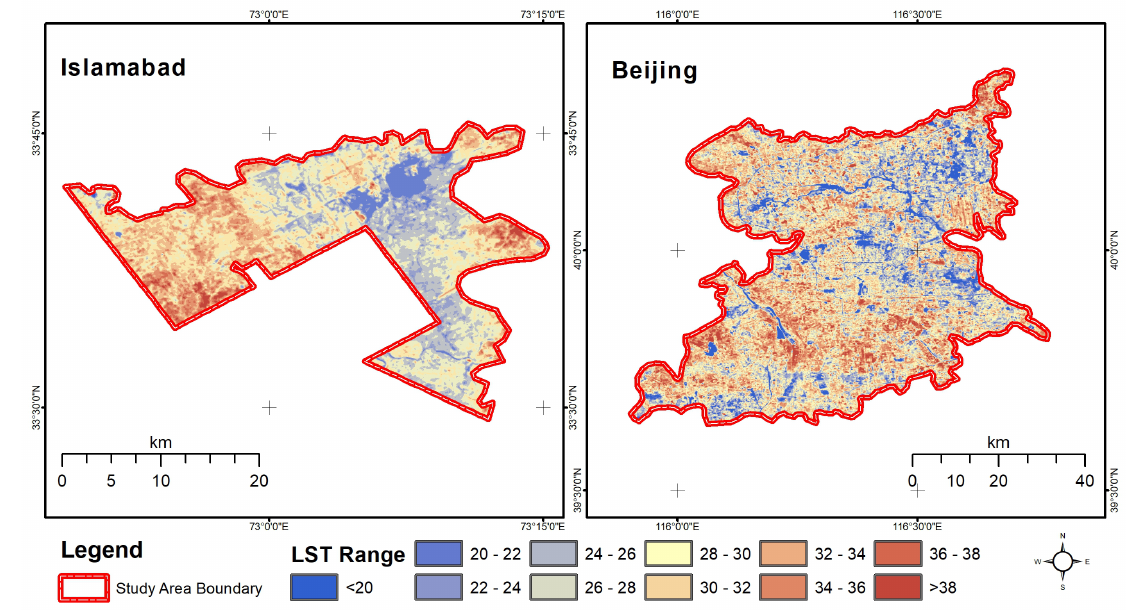
Figure 3. Land Surface Temperature of Islamabad and